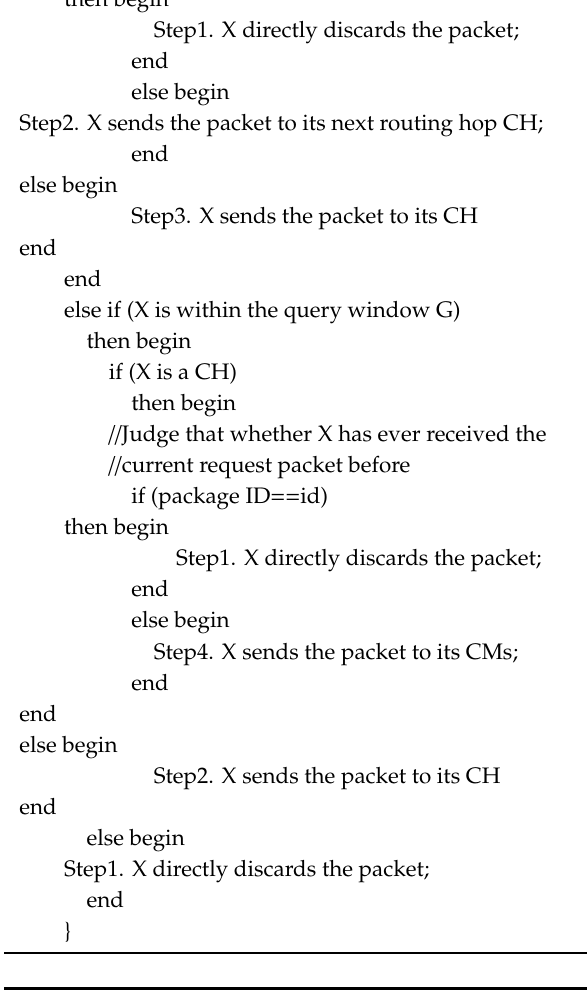
Algorithm 3 Sensor Data